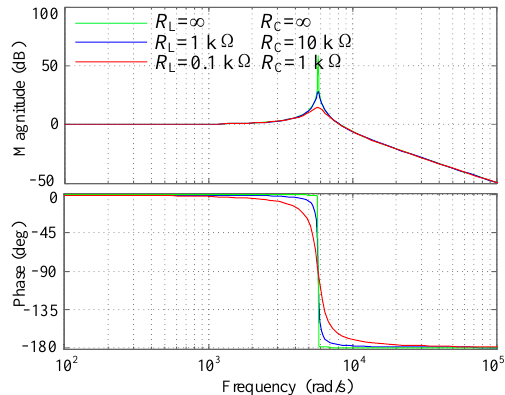
Figure 8. Bode plot of CL filter with damping.